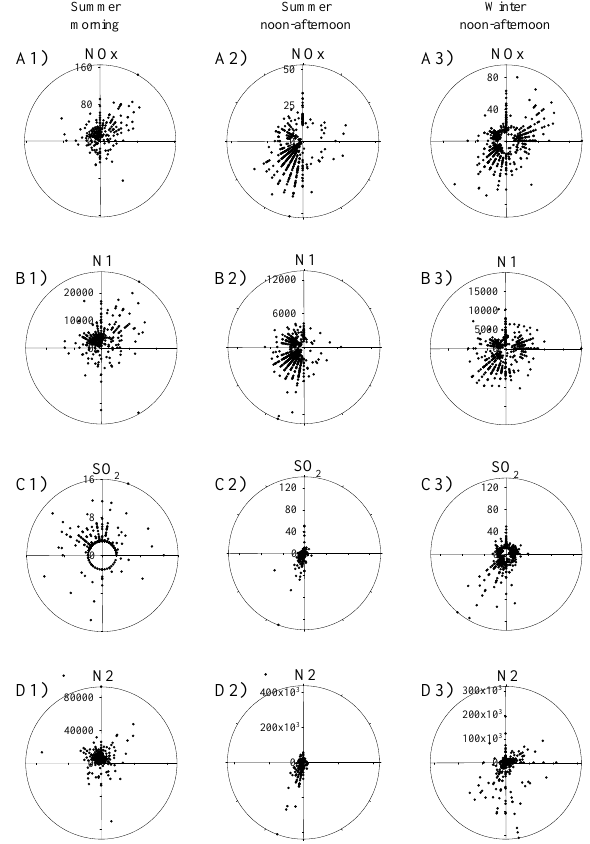
Fig. 7. Hourly mean values of N1 and N2 particles and of NO x and SO 2 concentrations during the summer morn- ing (06:00–09:00h), summer noon-afternoon and winter noon- afternoon (11:00–17:00h) as functions of wind